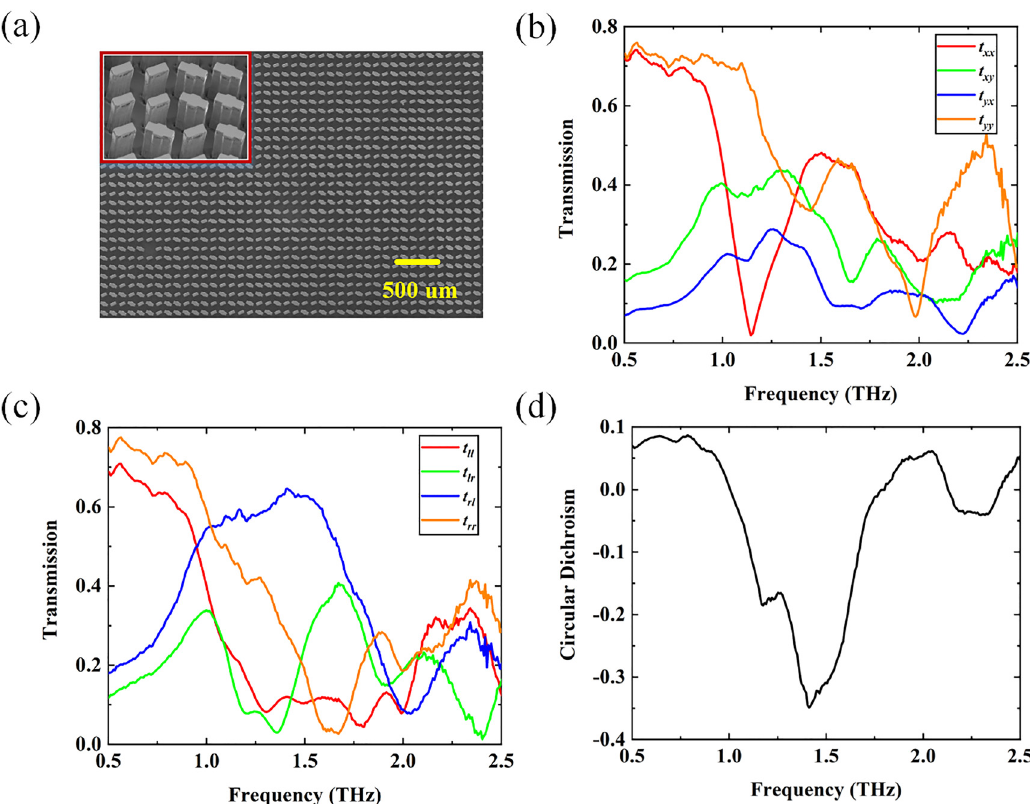
Figure 3: SEM images and experimental results of metasurface-1. (a) SEM images of part of the fabricated metasurface-1. (b) The measured transmissioncoefficients of the Jones matrix in the LP bases. (c) The measured transmission coefficients in the CP bases. (d) Transmission circular dichroism of the metasurface-1.